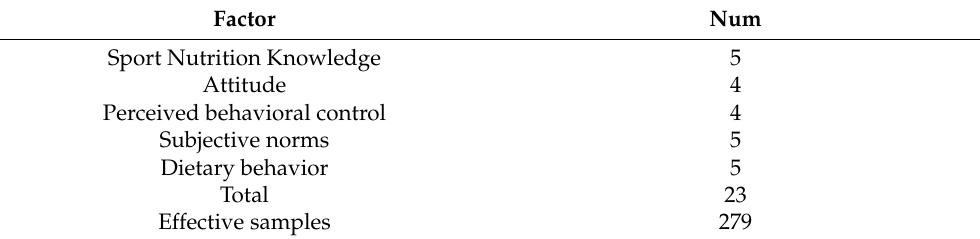
Table 1. CFA basic